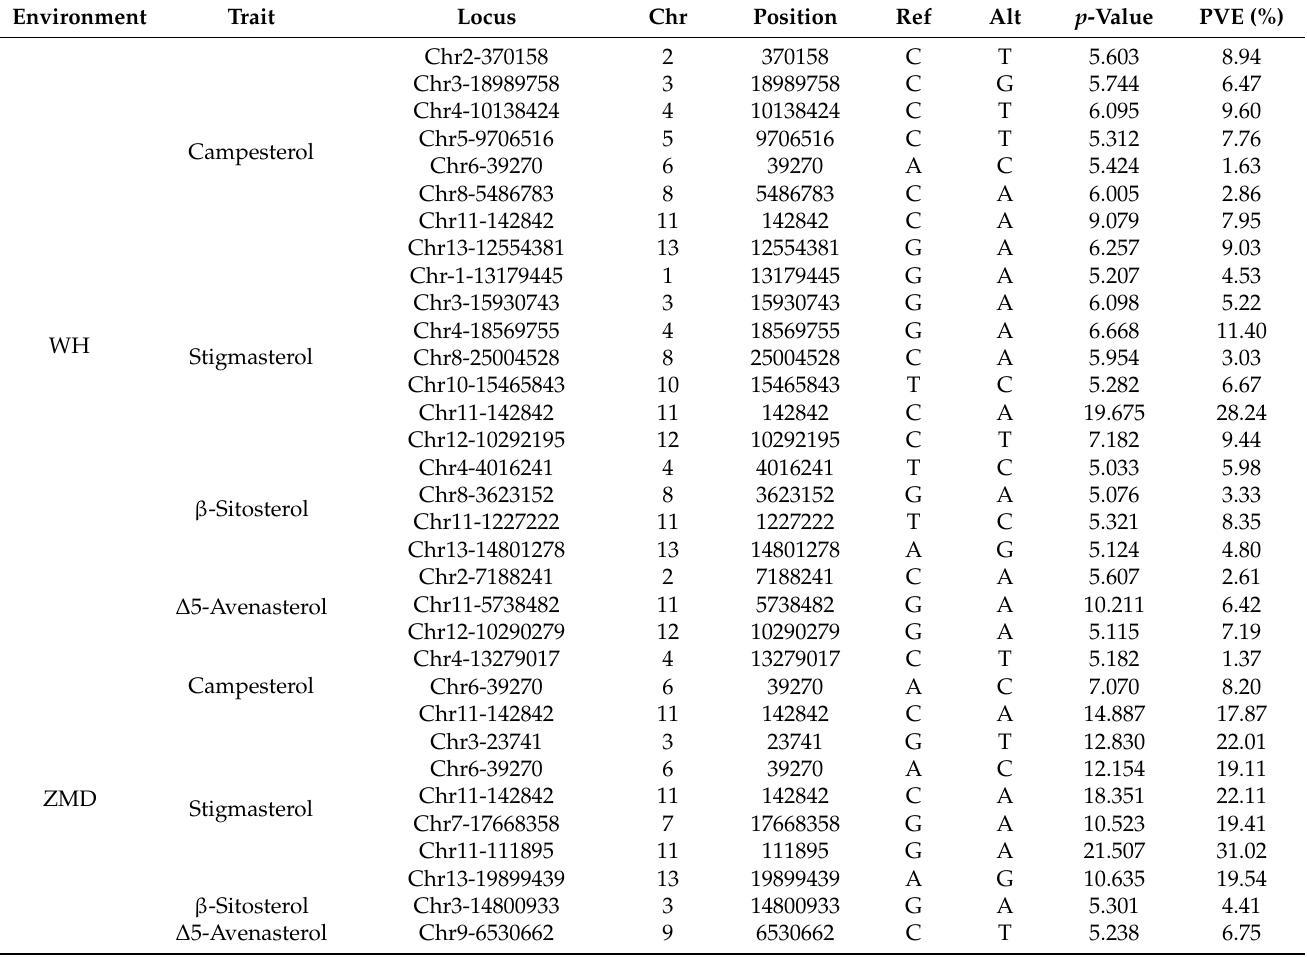
Table 2. List of the significant SNP loci associated with four phytosterol contents variation in